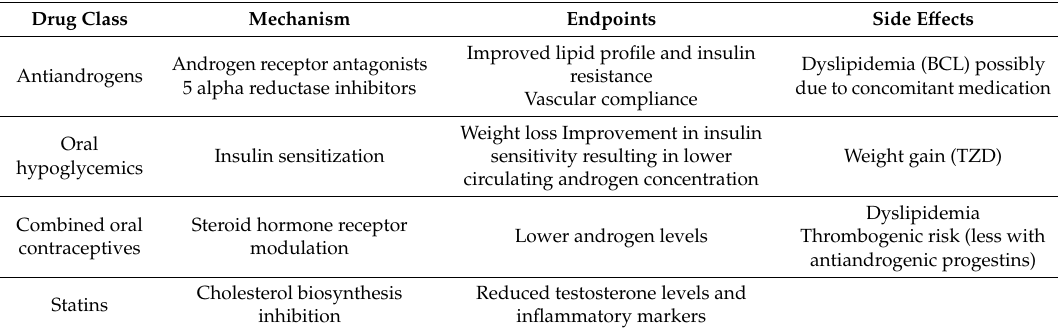
Table 1. A summary of pharmacological management of cardiometabolic risk factors in PCOS